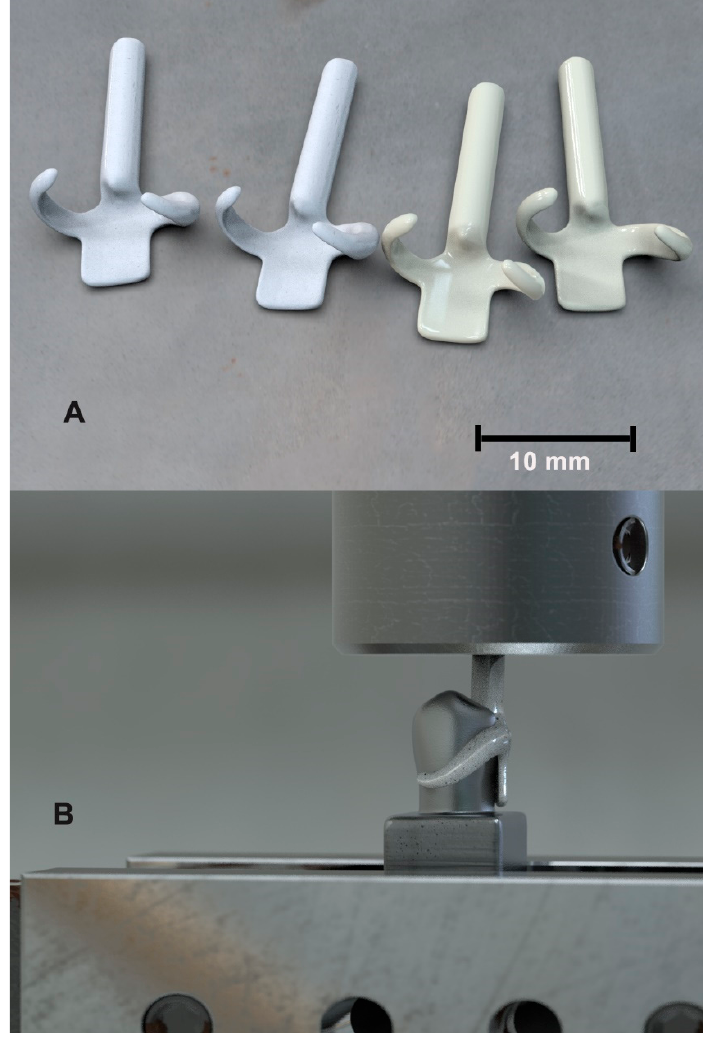
Figure 1. ( A ) Retentive and reciprocal arms of the CAD ‐ CAM ‐ prepared clasps with their attaching rods. ( B ) The manufactured clasp and tooth assembly attached in place in the testing machine.